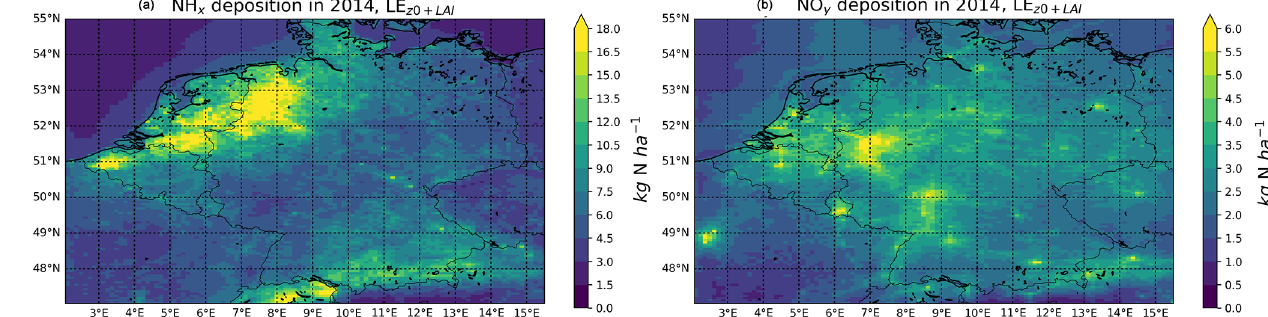
Figure 12. NH x deposition (a) and NO y deposition (b) in kgNha − 1 in 2014.